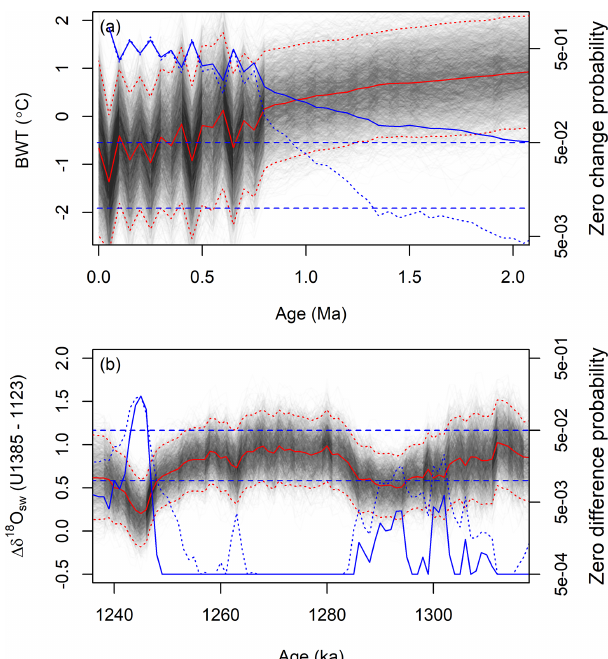
Figure 8. Evaluating changes within and between environmental reconstructions using JPI output. (a) Site 806 bottom water tem- perature reconstruction from ∼ 2Ma to present and probability of no significant change in temperature relative to modern. Gray and red lines show the BWT record. The blue solid line shows the JPI- estimated probability of no change relative to modern, calculated as the probability of a zero change value at each time step t given the posterior distribution BWT( t ) − BWT(0) values. The blue dot- ted line shows an equivalent estimate based on comparisons across posterior samples, calculated as the probability of the modern me- dian value given the posterior distribution of BWT values at time t . (b) Difference between site U1385 and 1123 seawater δ 18 O values within individual posterior samples (gray lines; red lines show mean and 95% credible intervals for the posterior), and probabilities of no significant difference between sites. Blue solid line shows the prob- ability of a zero difference value given the posterior distribution of differences between the two sites within individual posterior sam- ples. The blue dotted line shows an equivalent estimate based on differences between the two sites calculated from random samples of the single-site analyses. Blue dashed lines in both panels show 5% and 1% probability thresholds. See text for